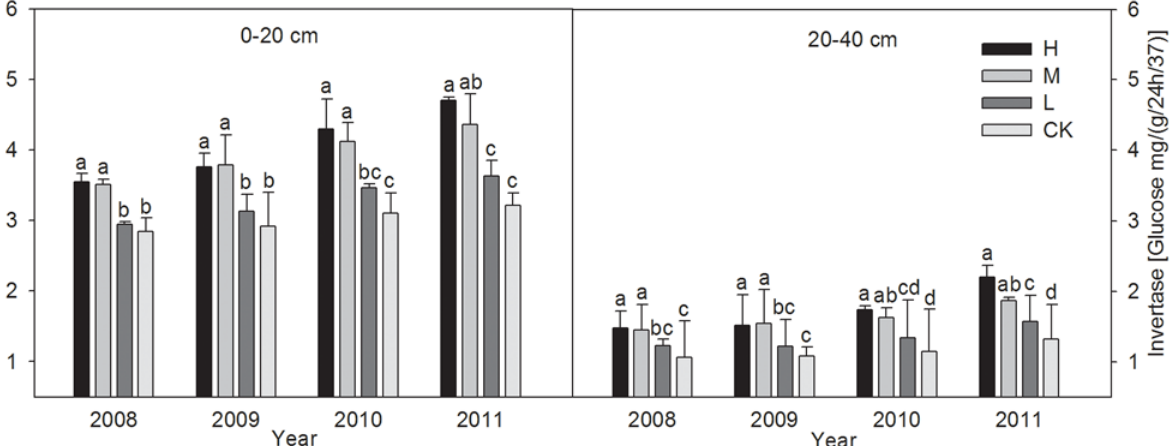
Fig 2. The changes of Invertase activities in 0 – 20 and 20 – 40 cm soil layers under different wheat straw incorporation treatments. Note: CK, no straw incorporation; L, incorporation of straw at a low rate of 3 000 kg hm -2 wheat straw; M, incorporation of straw at a medium rate of 6 000 kg hm -2 wheat straw; H, incorporation of straw at a high rate of 9 000 kg hm -2 wheat straw. Bars with different lowercase letters indicate significant differences ( P < 0.05).